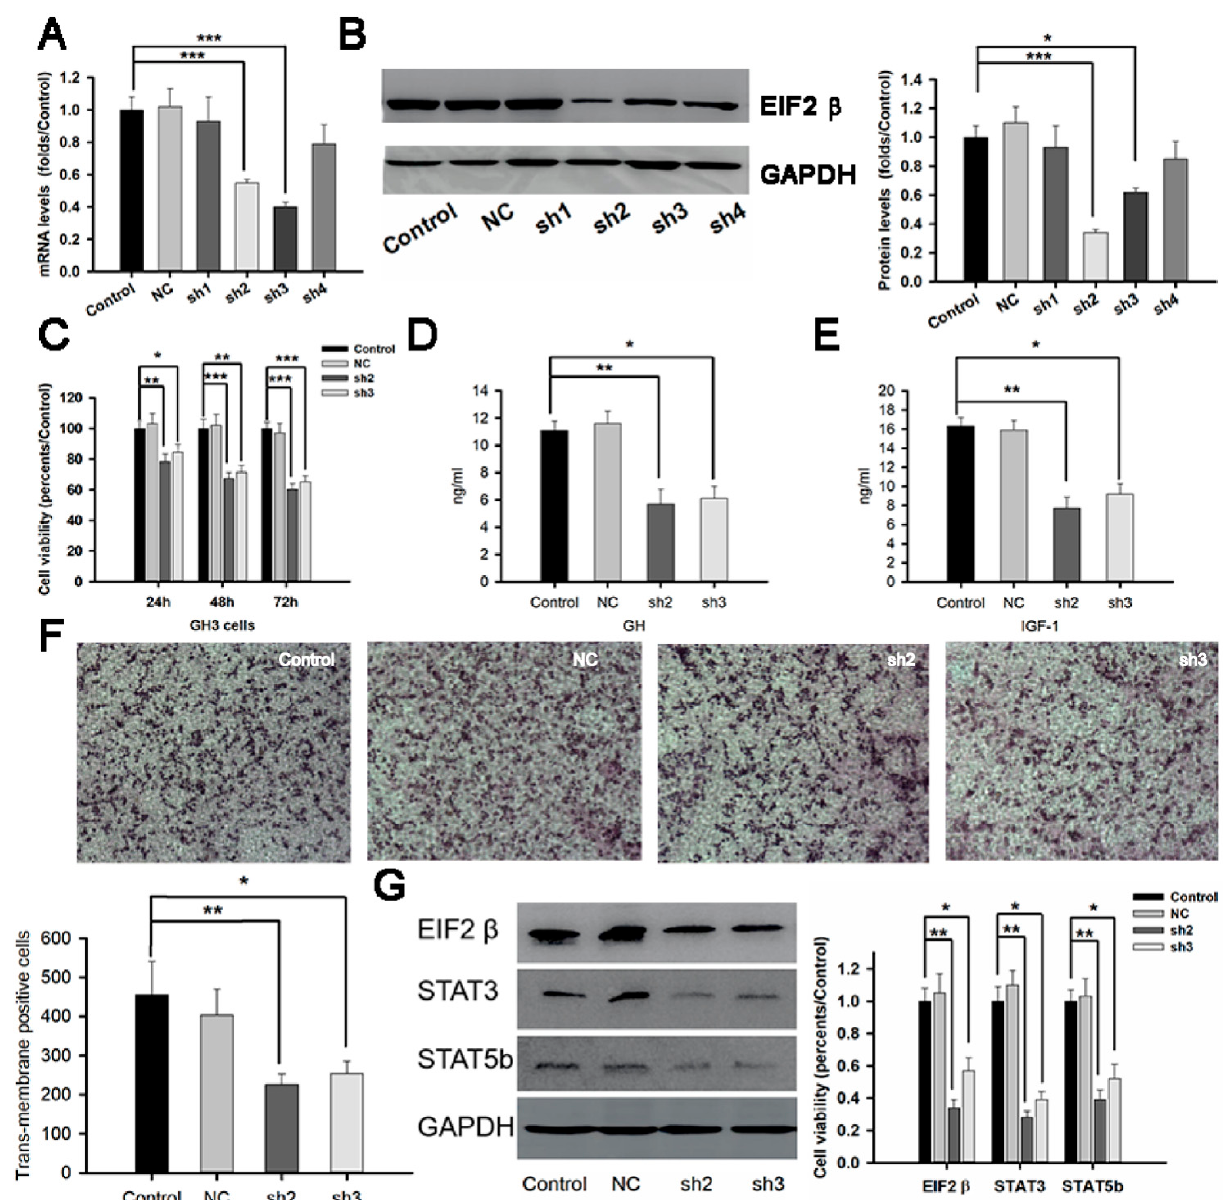
Figure 6. RNAi-EIF2 β inhibited cell proliferation, growth hormone secretion, and invasion in vitro. ( A , B ): RT-PCR and Western blot experiments filtered the effective interference fragments of EIF2 β in GH3 cells. ( C ): sh2-EIF2 β and sh3-EIF2 β reduced the cell viability of GH3 cells in a time-dependent manner. ( D ): sh2-EIF2 β and sh3-EIF2 β decreased growth hormone (GH) in GH3 cells. ( E ): sh2-EIF2 β and sh3-EIF2 β decreased insulin-like growth factor 1 (IGF-1) in GH3 cells. ( F ): sh2-EIF2 β and sh3-EIF2 β decreased trans-membrane-positive cells after 24 h treatment. ( G ): sh2-EIF2 β and sh3-EIF2 β reduced protein levels of STAT3 and STAT5b after 24 h treatment. * Compared to control group p < 0.05 ** p < 0.01 *** p < 0.001.